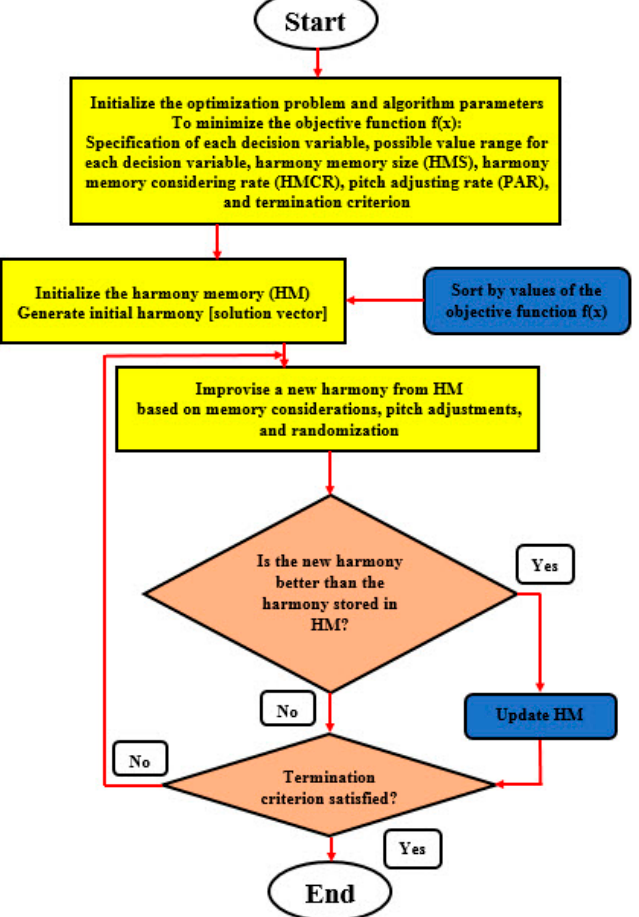
Figure 1. Flowchart of the HS.